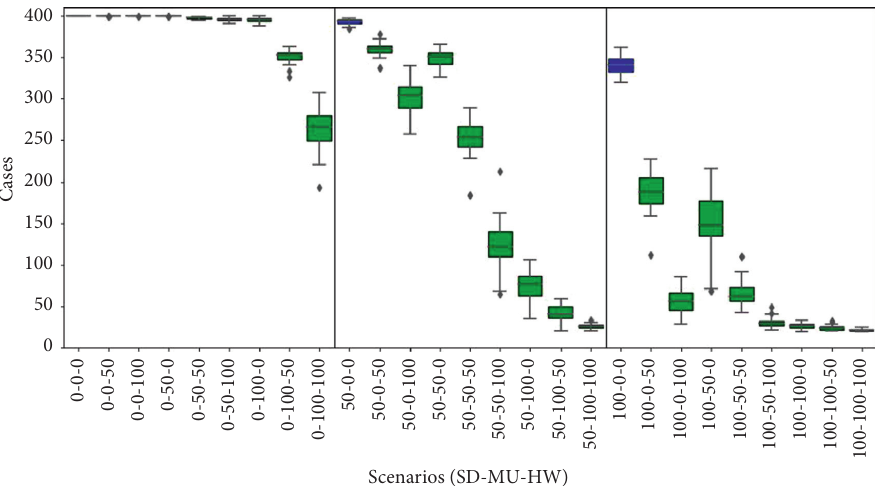
Figure 5: Cases results. Box plots represent average and standard deviation of the cumulative count of infections in the population. Scenarios are labelled according to the willingness of agents to adhere to personal health habits such as social distance, mask user, or hands washer (SD%, MU%, and HW%). Baseline scenarios were defined varying the proportion of social distancers in the population assuming no agents adopt using masks or washing hands. In each panel, the baseline scenario is coloured blue (left, 0%-0%-0%; middle, 50%-0%-0%; right, 100%-0%-0%). Scenarios with statistical significant difference compared to their corresponding panel baseline (blue) are coloured green ( p value < 0 : 05); otherwise, they are coloured